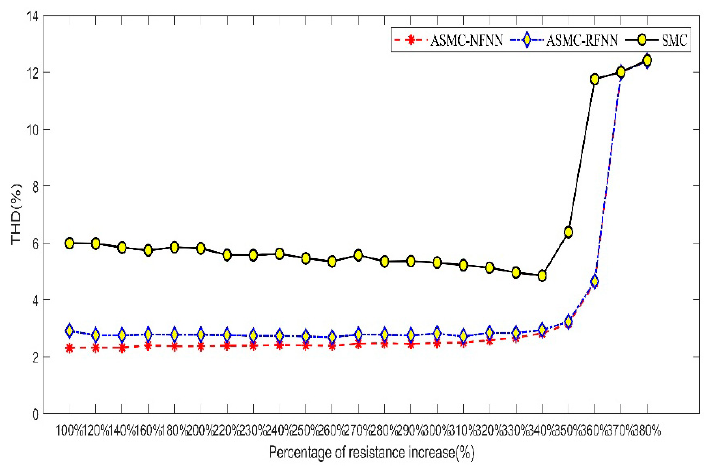
Figure 20. Performance comparison curve of resistance parameter changes.